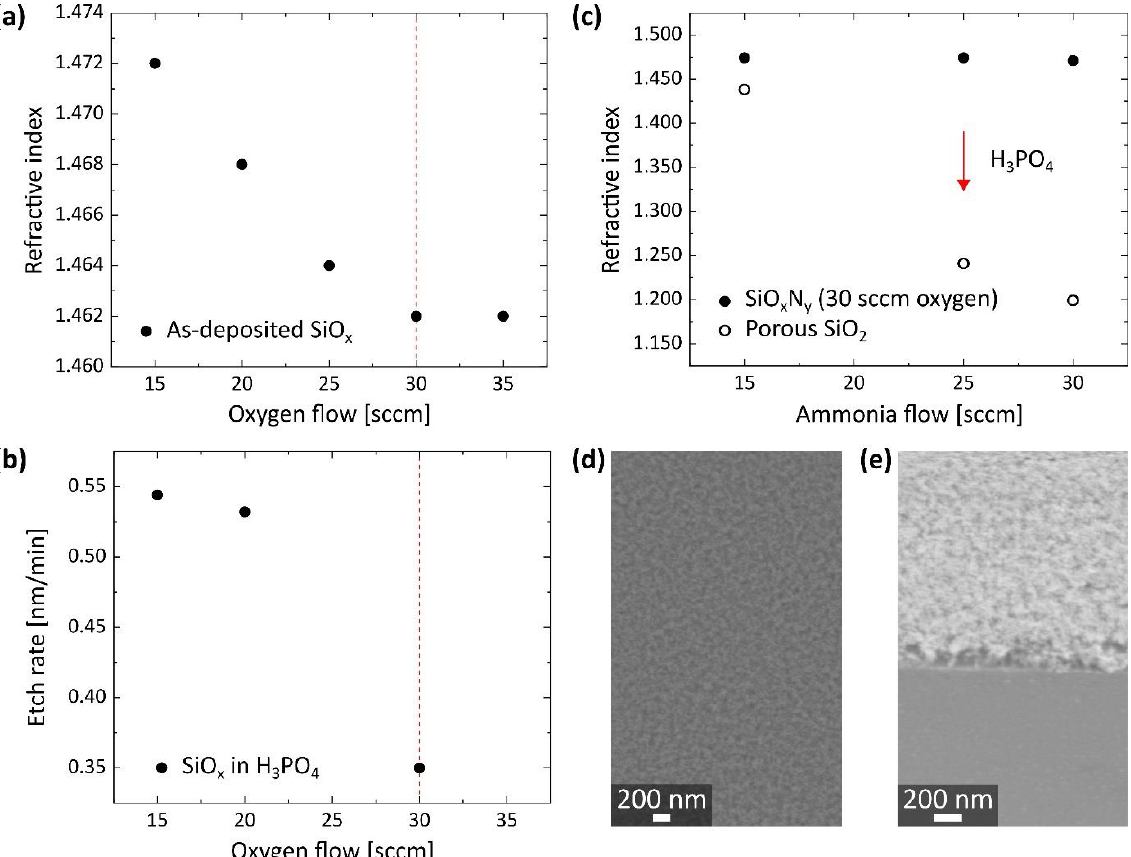
Figure 1. Synthesis of porSiO 2 by selective wet etching of PECVD SiO x N y . ( a ) The RI of PECVD SiO x decreased gradually with increasing oxygen flow and reached a minimum of 1.462 for 30 sccm. ( b ) The PECVD SiO x deposited with 30 sccm oxygen exhibited the strongest resistance to boiling H 3 PO 4 . ( c ) The RI reduction by selective wet etching of SiO x N y in boiling H 3 PO 4 was enhanced with increasing ammonia flow in the PECVD recipe. The lowest effective RI of porSiO 2 was achieved by wet etching of SiO x N y that was deposited with 30 sccm oxygen and 30 sccm ammonia. ( d ) Top and ( e ) side view SEM images of porSiO 2 with an effective RI of 1.206 and a thickness of 52 nm. The SEM images were taken with the Supra 55 by Zeiss and the side view was taken at an angle of 30°.